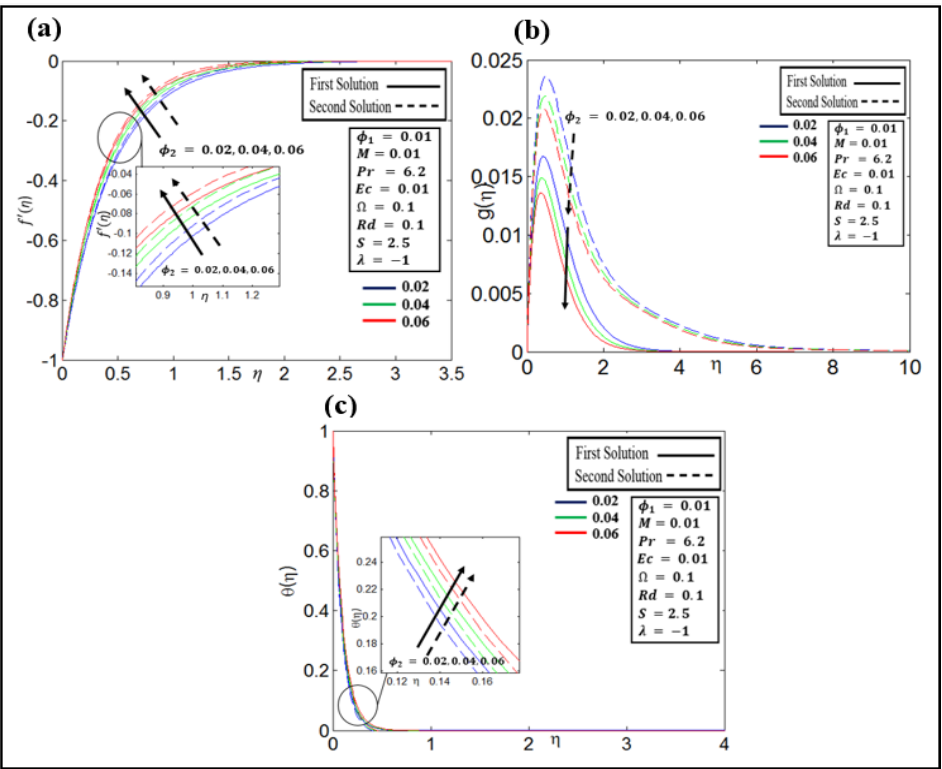
Figure 5. ( a – c ): Profiles of velocity f (cid:48) ( η ) , g ( η ) , and temperature θ ( η ) for different φ 2 . Table 4. The results of the Eckert number 𝐸𝑐 when 𝜙 (cid:2869) = 0.01 , 𝜙 (cid:2870) = 0.03 , 𝑆 = 2 , 𝜔 = 0.01 , 𝑀 = 𝑅𝑑 = 0.1,𝜆 = −1 , and 𝑃𝑟 = 6.2 .